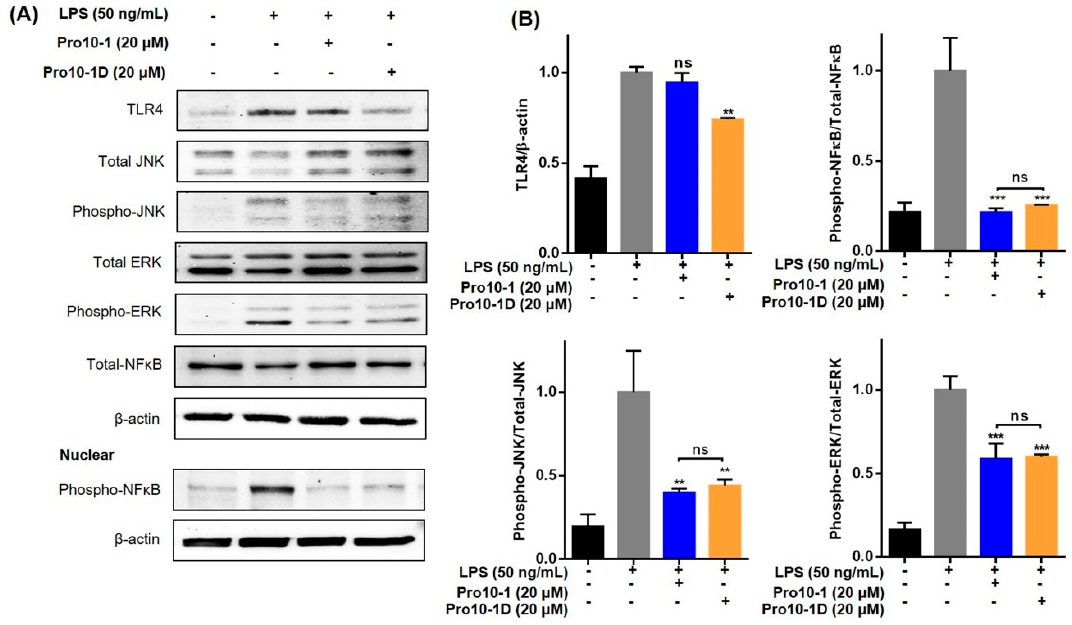
Figure 10. Pro10-1D is a target of toll-like receptor 4 (TLR4) and downregulates MAPK and NF- κ B translocation in LPS-stimulated RAW264.7 cells. ( A ) Immunoblot analysis revealed the suppression of LPS-mediated TLR4, total / phospho-JNK, total / phospho-ERK, and cytosolic and nuclear translocation of NF- κ B in RAW264.7 cells treated with peptides (20 µ M) and LPS (50 ng / mL). β -actin was used as an internal control. ( B ) Graphical data represent the densitometry analysis of respective proteins, quantified by ImageJ. The values are expressed as the mean ± SEM of three independent experiments and are statistically significant, based on one-way ANOVA ( Tukey’s post hoc test , ** p < 0.01, and *** p < 0.001; ns, not significant).